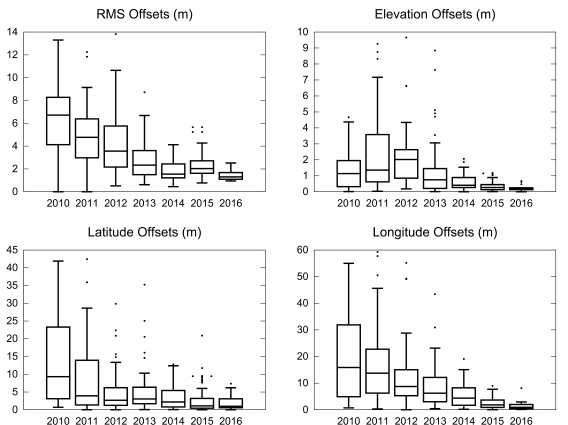
Figure 2. Boxplots representing offsets between NAC DTMs and LOLA profiles over the course of LROC NAC DTM production. Updated from Henriksen et al.